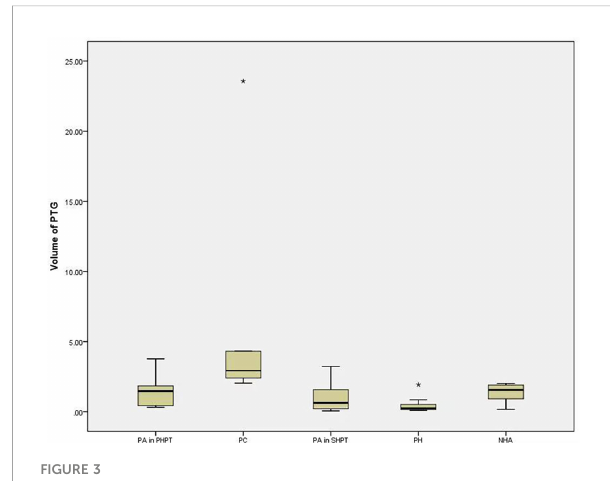
FIGURE 3 The difference of volume of PTG in subgroups. Boxplots indicate median value (black), fi rst and third quartile range (box). Pairwise comparison by independent sample Kruskal-Wallis test, PH and PA in PHPT were statistically signi fi cant (P=0.023), PH and PC were statistically signi fi cant (P< 0.001), PA in SHPT and PC were statistically signi fi cant (P=0.025). PTG, parathyroid gland. PA in PHPT, parathyroid adenomas in primary hyperparathyroidism. PC, parathyroid carcinomas; PA in SHPT, parathyroid adenomas in secondary hyperparathyroidism; PH, parathyroid hyperplasia; NHA, nodular hyperplasia with adenoma. * indicates that the value is an outlier, which is far away from the third quartile